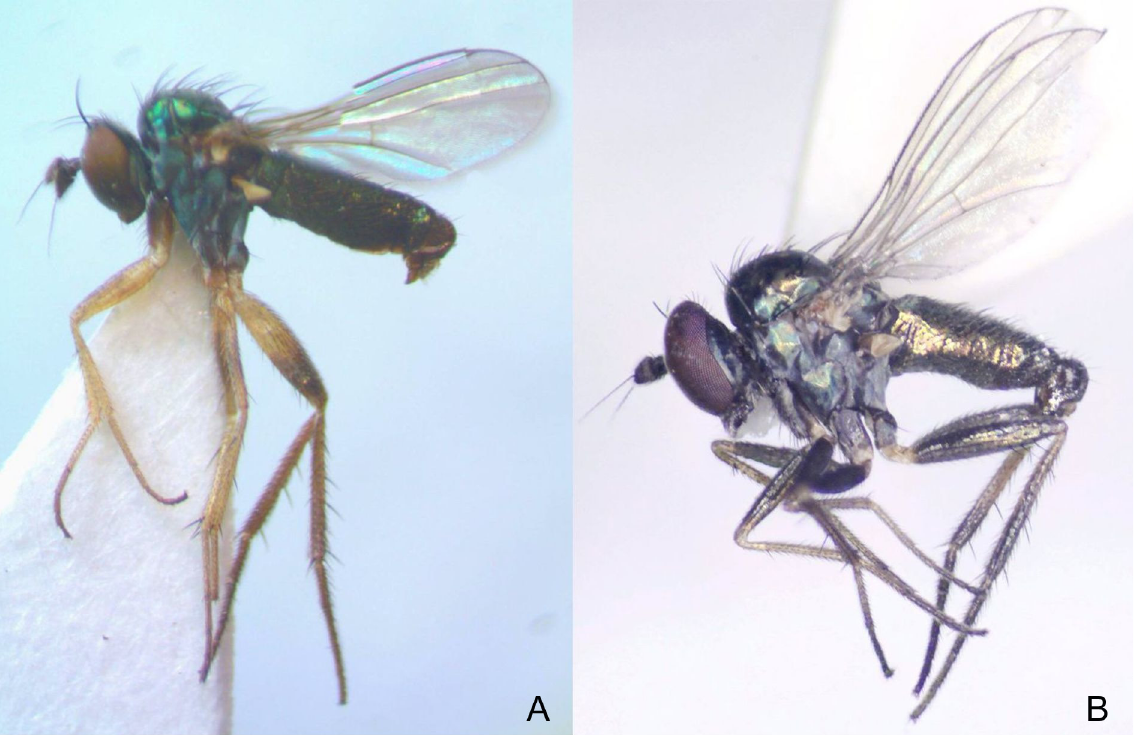
Fig. 5. Male habitus, lateral view. A . Chrysotus masunagai Negrobov, Kumazawa & Tago sp. nov., ♂, paratype, coll. 15 May 2010. B . Chrysotus saigusai Negrobov, Kumazawa & Tago sp. nov., ♂, paratype, coll. 8 Jul.